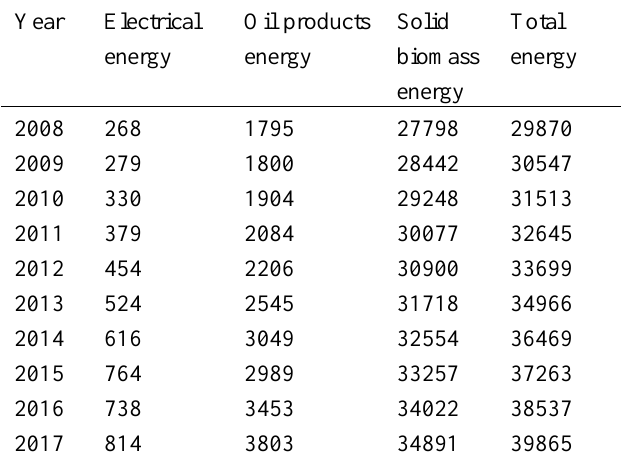
Electric, oil products, solid biomass and total energy consumption data of Ethiopia from 2008 to 2017, (Unit: kilo- tons of oil equivalent